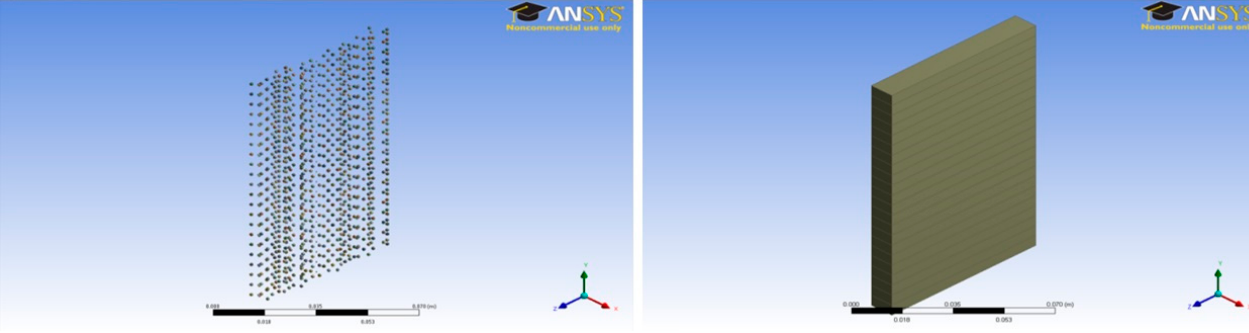
Figure 7. Three percent fine aggregate sample model (11 × 7 × 1 cm) and concrete slab.